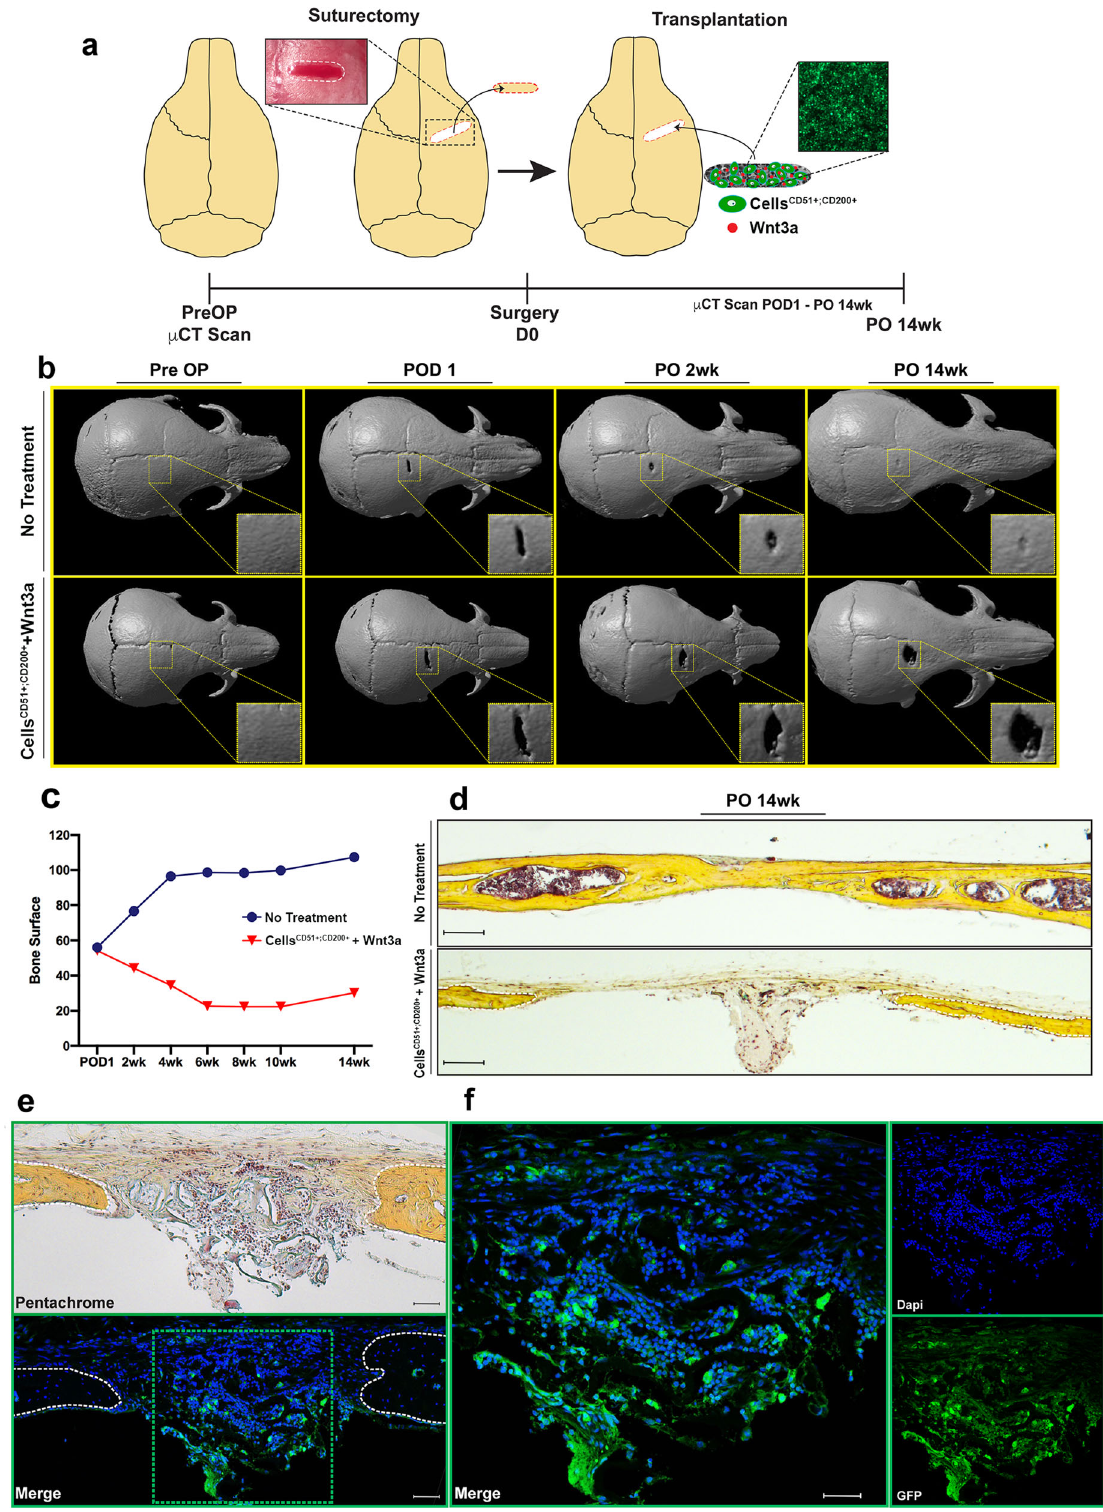
skeletal stem/progenitor cells coached with effectors of cWnt signaling as an early intervention therapy for